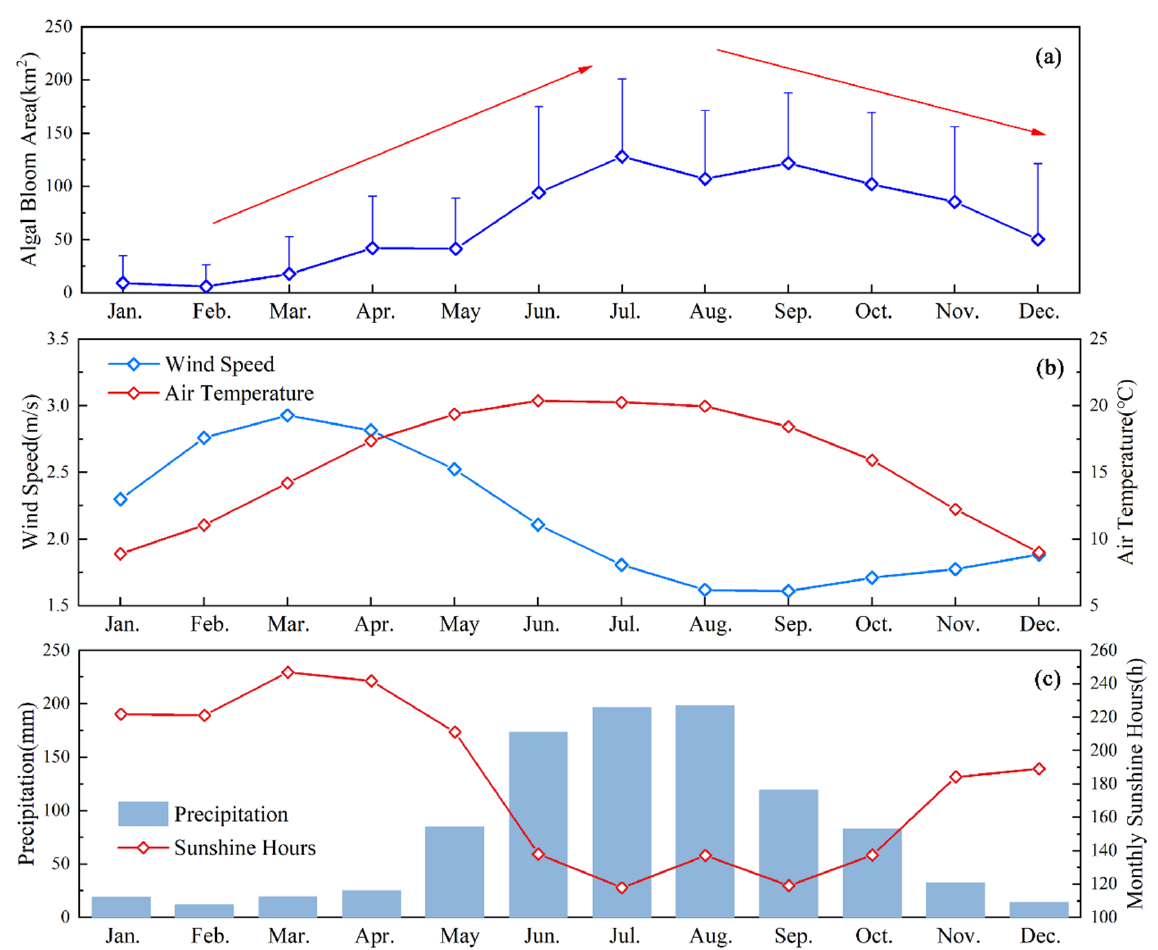
Figure 5. ( a ) Monthly algal bloom area in Lake Dianchi generated from all Landsat and MODIS/Terra images during 1987–2021. ( b ) Monthly wind speed and air temperature in Lake Dianchi. ( c ) Monthly precipitation and hours of sunshine in Lake Dianchi.